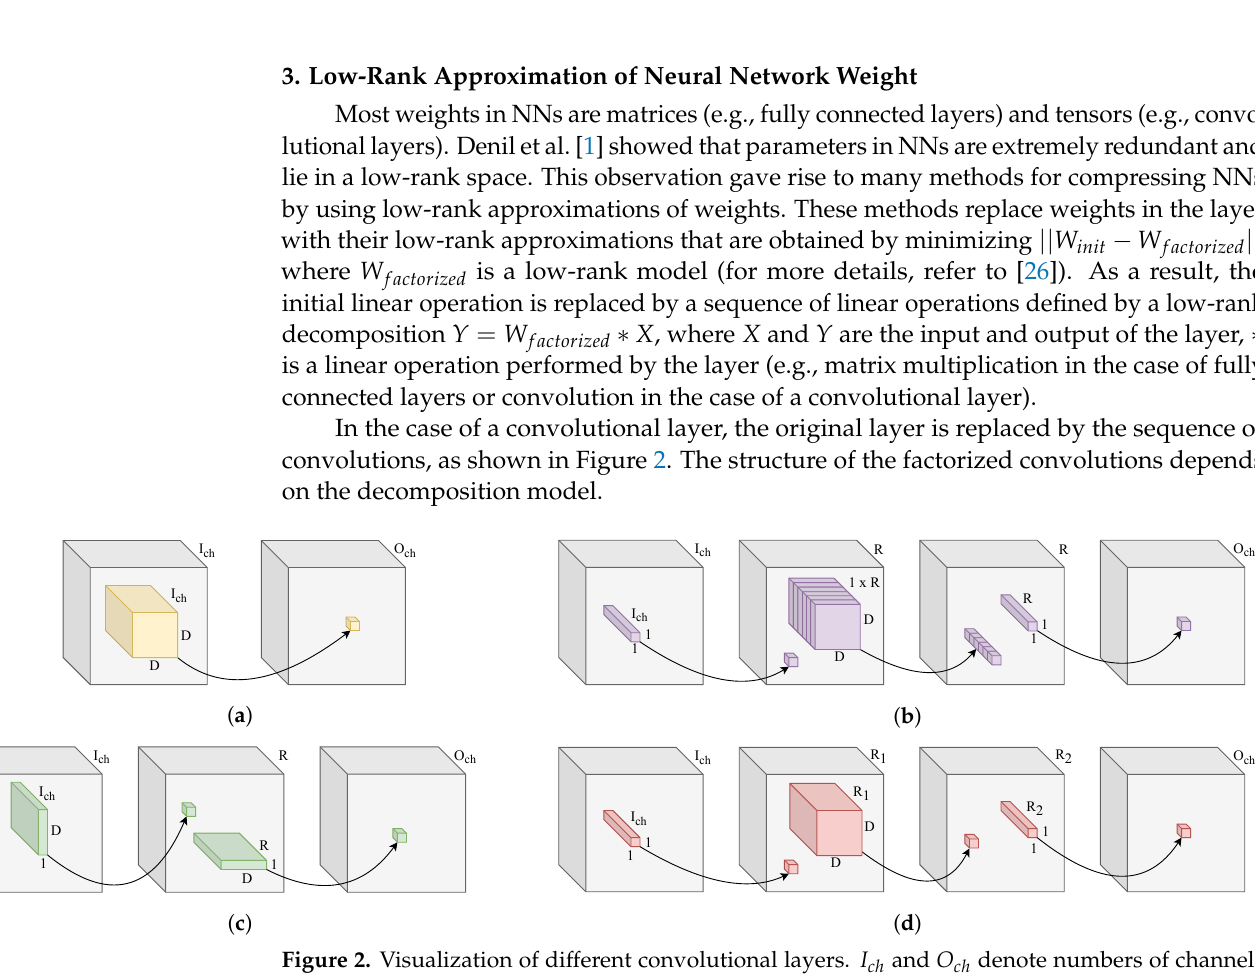
Figure 2. Visualization of different convolutional layers. I ch and O ch denote numbers of channels in the input and output, respectively, D denotes the size of the convolutional layer, and R , R 1 , and R 2 denote the decomposition ranks. ( a ) Original convolutional layer. ( b ) CPD-3 layer. ( c ) Spatial- SVD layer. ( d ) TKD-2